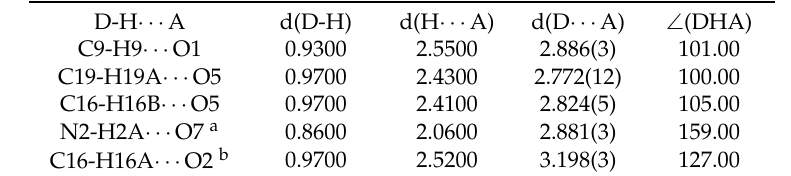
Table 3. Hydrogen bonding data for compound 6b (Å, ˝